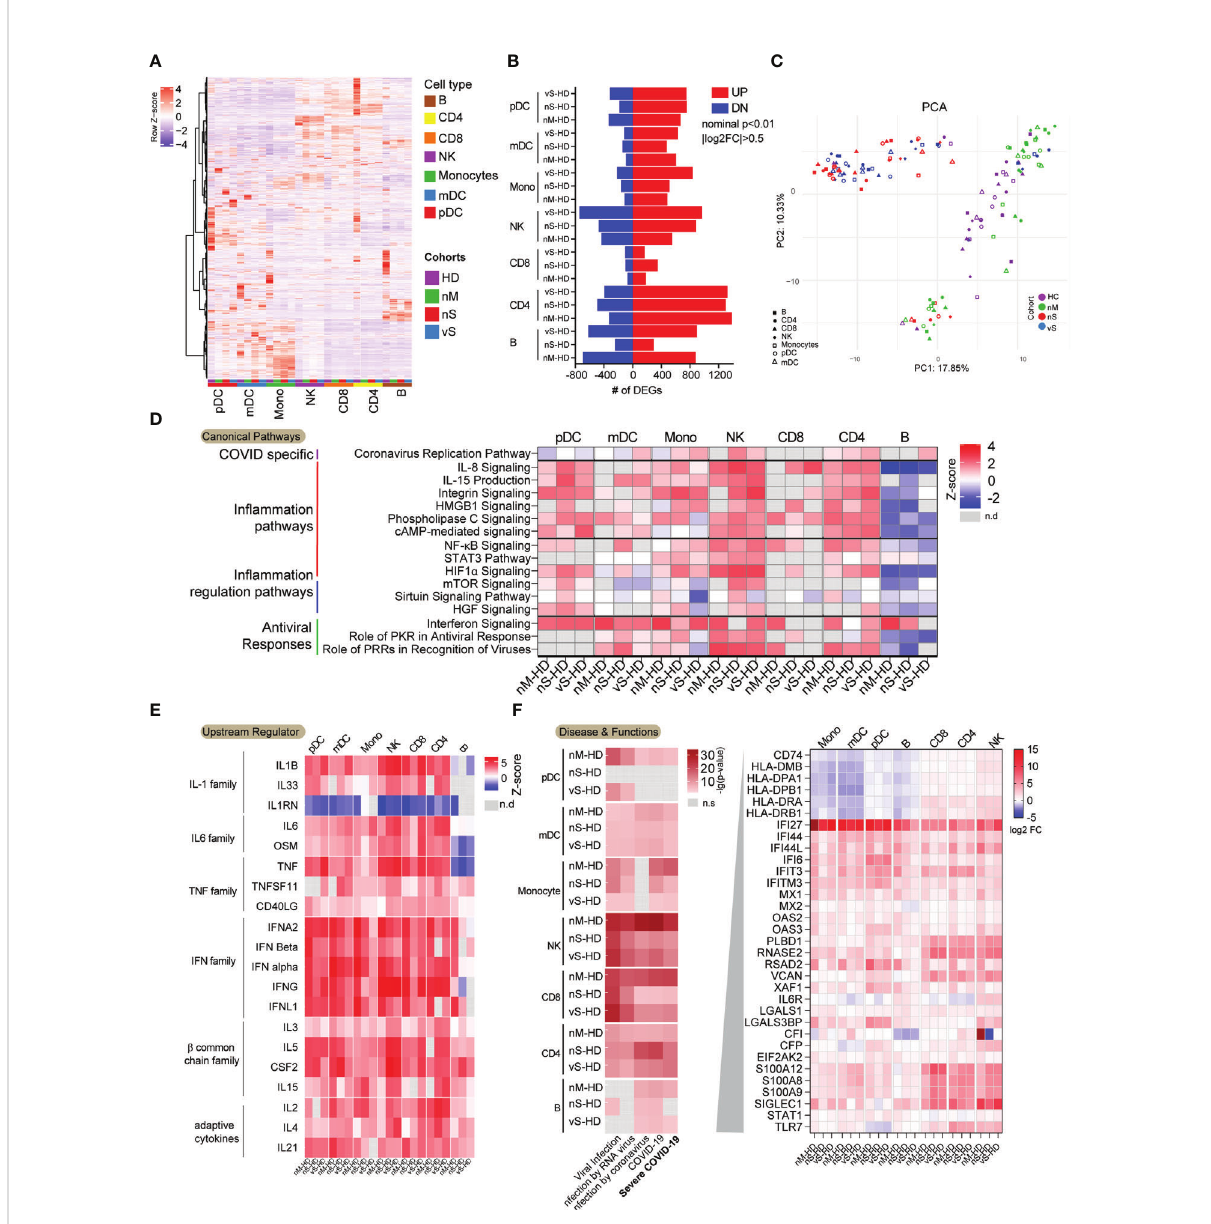
FIGURE 2 Dysregulated transcriptional immune pro fi les in COVID-19 infection. (A) Heatmaps demonstrated transcriptional patterns of highly variable genes (n=3452) among the three groups of COVID-19 patients and the non-infected individuals in indicated immune cell subsets. The colored square on the bottom of the heat map indicated the cell types and study cohort information. (B) Bar diagram indicating the total number of upregulated (red) and downregulated (blue) genes in indicated cell populations from three groups of COVID-19 patients relative to non-infected individuals (|FC| = 0.5, nominal p< 0.01). Each pathway was grouped according to its functions. (C) PCA analysis of global transcriptional signatures from indicated cell populations derived from COVID-19 group, nM(green), nS(red), vS(blue), and healthy control (HD, purple). (D) Common Canonical pathways inferred by IPA from DEGs between COVID-19 patients and non-infected individuals in indicated immune cell subsets. Pathways were grouped by functions. Red and blue denote functional pathways predicted to be up or downregulated, respectively; gray indicates indeterminate directional. (E) Common predicted upstream regulators for genes differentially expressed between indicated immune cell subsets from COVID-19 patients and non-infected individuals. Color coding re fl ects a z-score, indicating activation or inhibition of the upstream regulators. Missing values were in gray. (F) Diseases and Functions inferred by IPA involving virus infections were shown. The red gradient indicated the p-value and missing value in gray. The genes related to severe COVID-19 were listed, and expression levels (log2FC) were shown in indicated immune cell